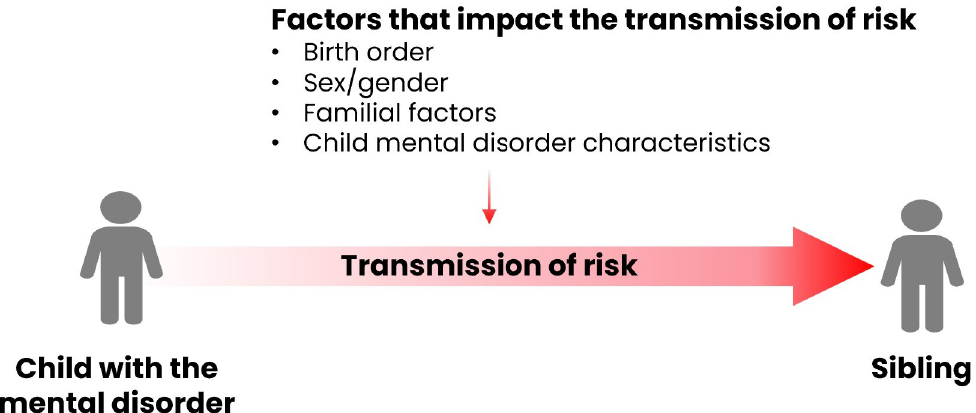
Fig 1. The transmission of risk from the child in the family with a mental disorder to their